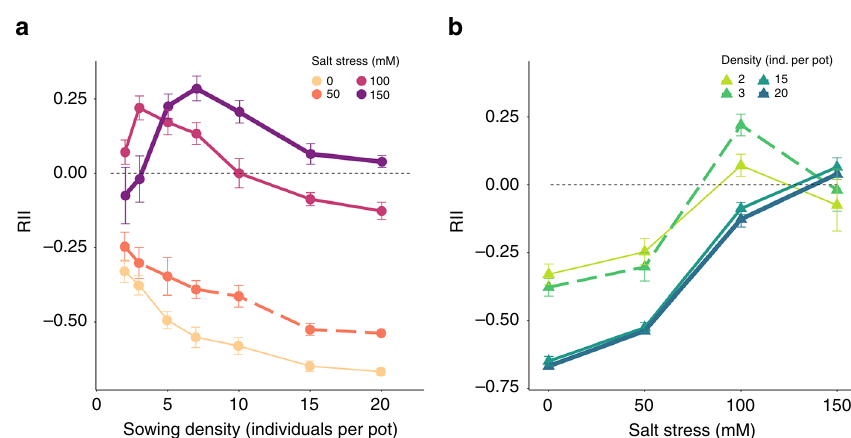
Fig. 3 The change of density-dependent interactions under salt stress in the experiment. a Relationship between initial density and average relative interaction index (RII; data are presented as mean values± SEM) for biomass of Arabidopsis thaliana grown along a salinity gradient in a greenhouse experiment. b Plant – plant interactions change along the stress gradient, showing that the SGH applies at high densities but not at low densities. Circles represent different stress levels while triangles and lines represent different density levels. For the density gradient from 2 to 20 plants per pot, n salt_0 = 25, 29, 17, 16, 15, 15, and 16 independent pots, respectively; n salt_50 = 20, 25, 13, 17, 16, 13, 16; n salt_100 = 30, 26, 15, 12, 14, 14, 13; n salt_150 = 29, 30, 15, 16, 17, 12, 11. Note that for facilitating visual interpretation, we only show the two lowest and two highest densities (changes in the RII for intermediate densities were similar and ranged in between the extreme scenarios shown here). Source data are provided as a Source Data fi le.